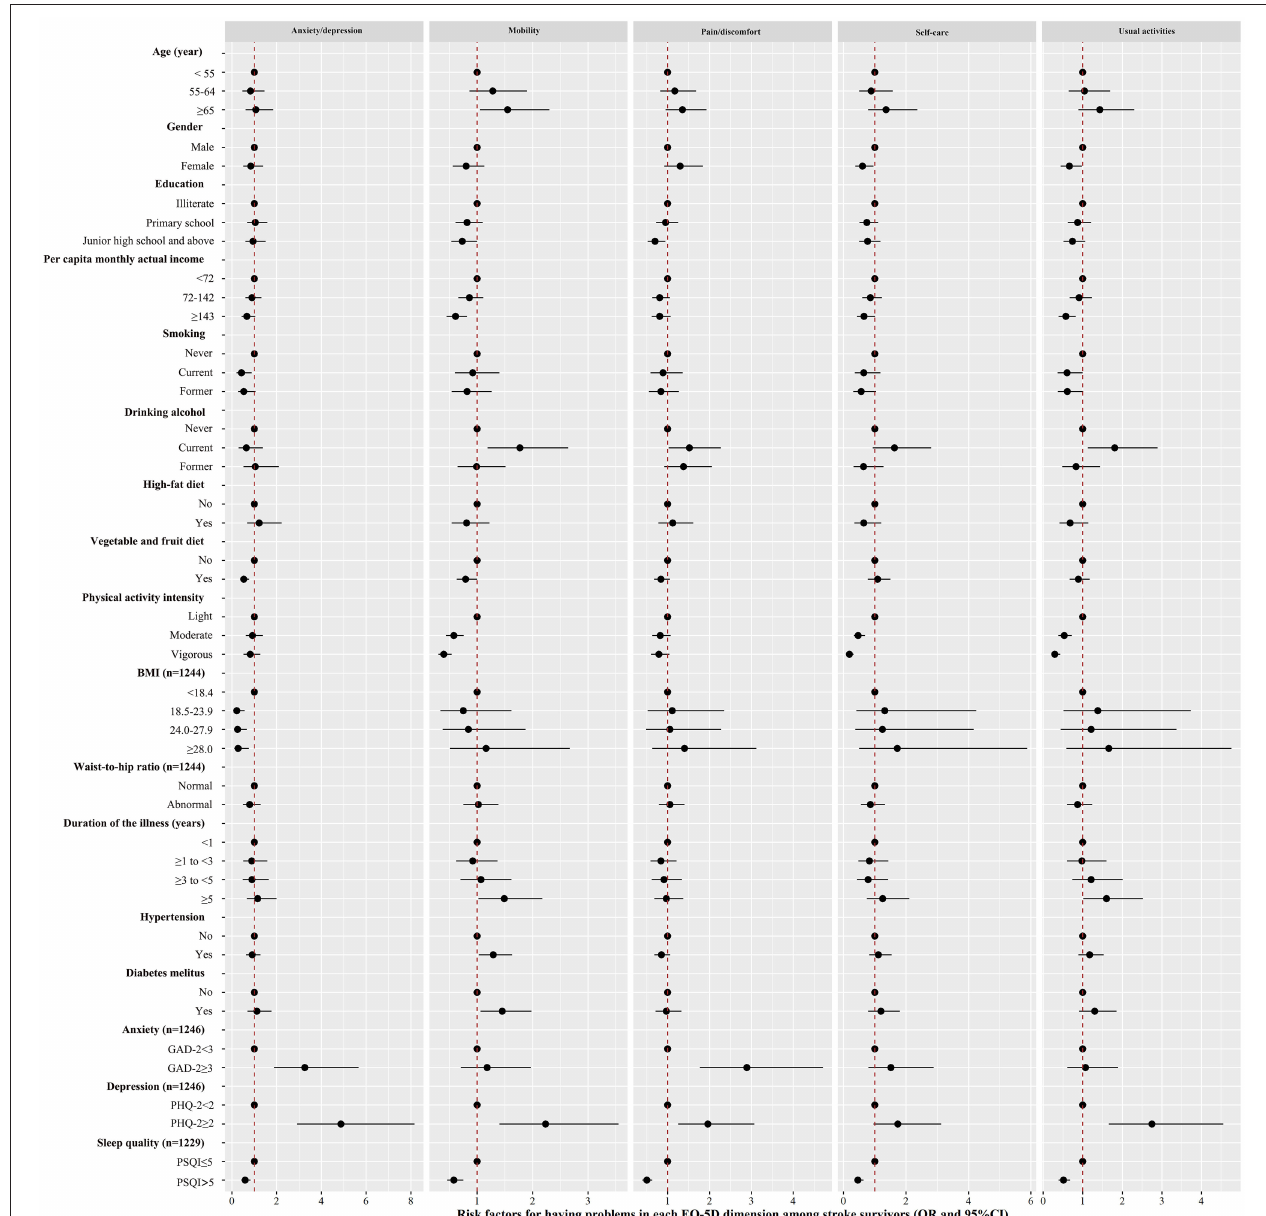
FIGURE 2 | The risk factors for low scores in each EQ-5D dimension [Mobility, Self-care (SC), Usual activities (UA), Pain/discomfort and Anxiety/depression (AD)] among patients with stroke ( n = 1,709) identified by multiple logistic regression analysis. The black dots with the corresponding error bars represented the estimated effect and 95% confidence intervals of the change in each of variables. A two-sided P -value 0.05 was considered statistically